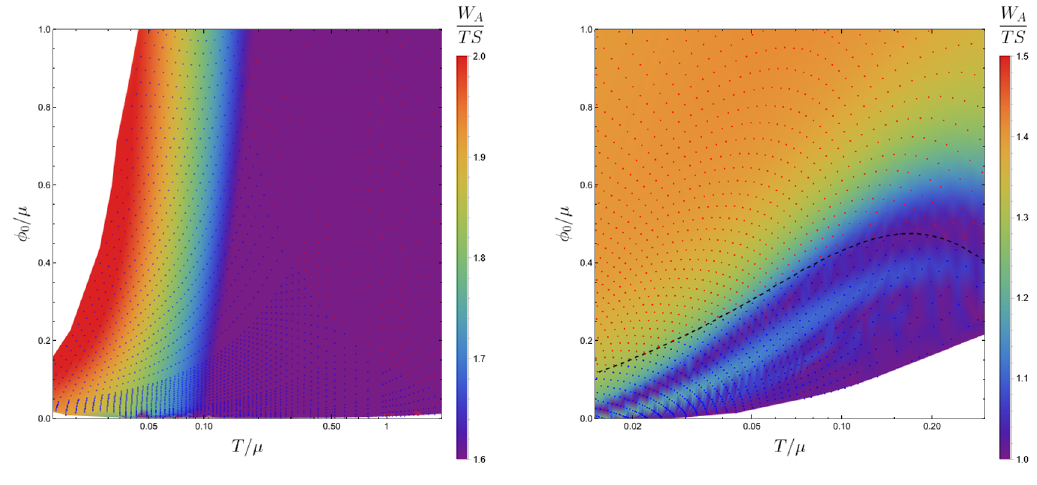
Figure 24 . Left: neutral scalar case q = 0 . Right: charged scalar case with q = 1 . Red points denote type D solutions, black points denote type U solutions. The white region is not covered by our numerics.